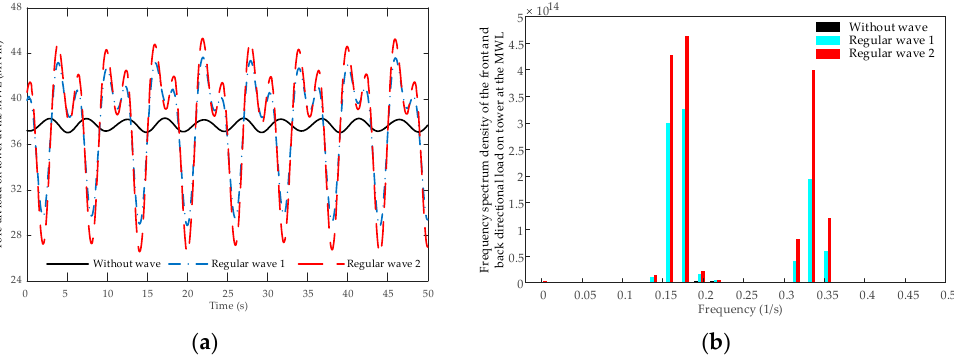
Figure 4. Time domain and frequency domain results of the fore-aft load on tower at the MWL without and with regular wave: ( a ) The fore-aft load on tower at the MWL; ( b ) Frequency spectrum density of the fore-aft load on tower at the MWL.